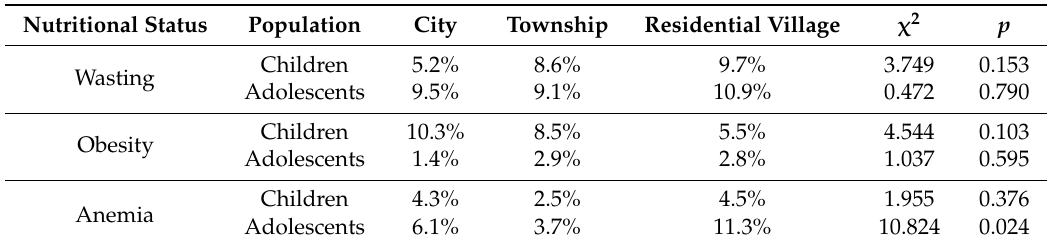
Table 1. The percentages of wasting, obesity and anemia among children and adolescents living in city, township and residential village.